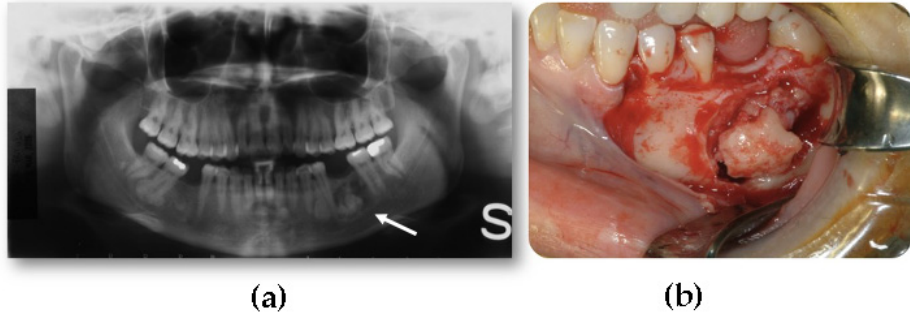
Figure 9. A case of a mandibular osteoma. ( a ) The panoramic radiograph demonstrates a focal radi- opaque lesion (white arrow); ( b ) Osteoma’s surgical removal via the transoral approach